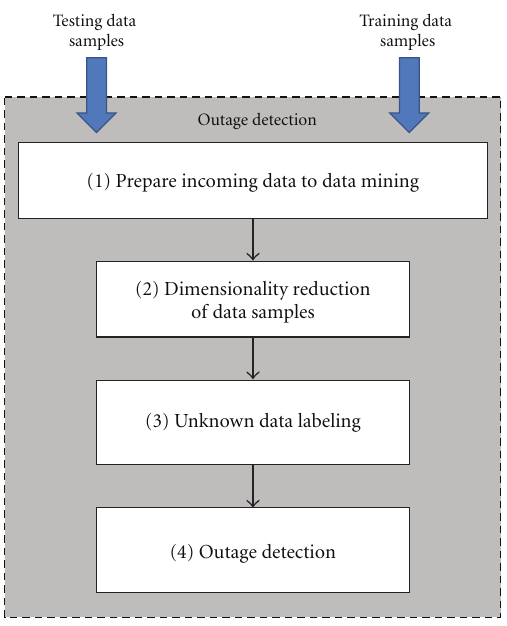
Figure 3: Data-mining outage detection-phase